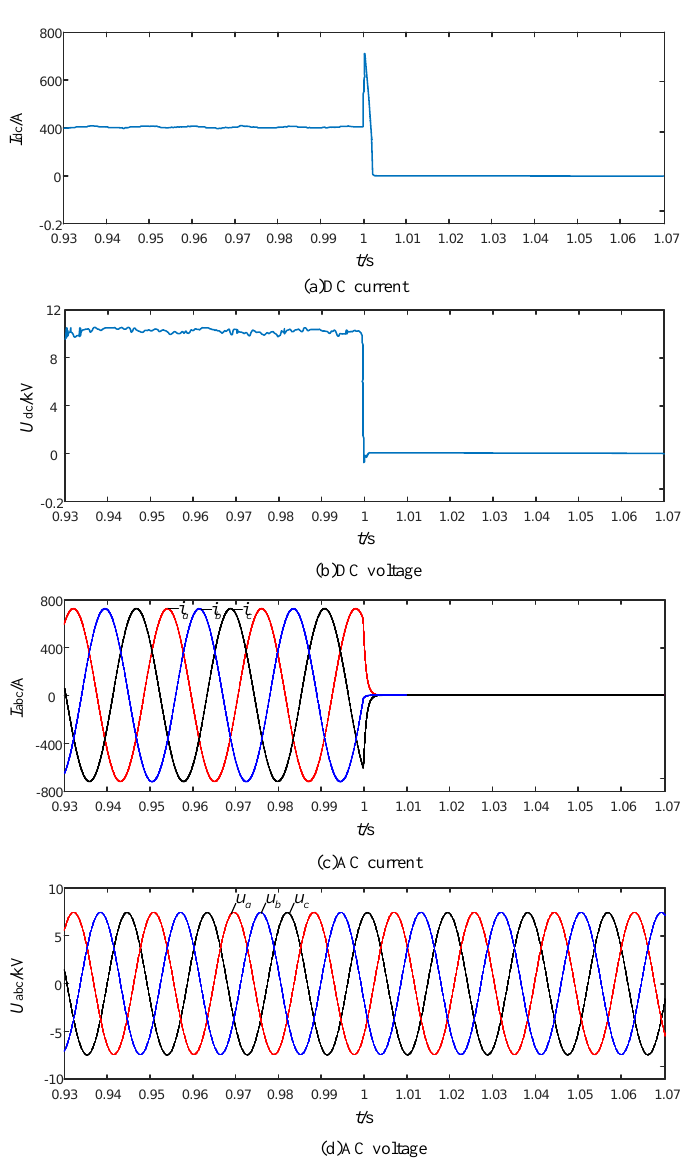
Figure 10. Bipolar fault waveform on the DC side: ( a ) DC current; ( b ) DC voltage; ( c ) AC current; ( d ) AC voltage.